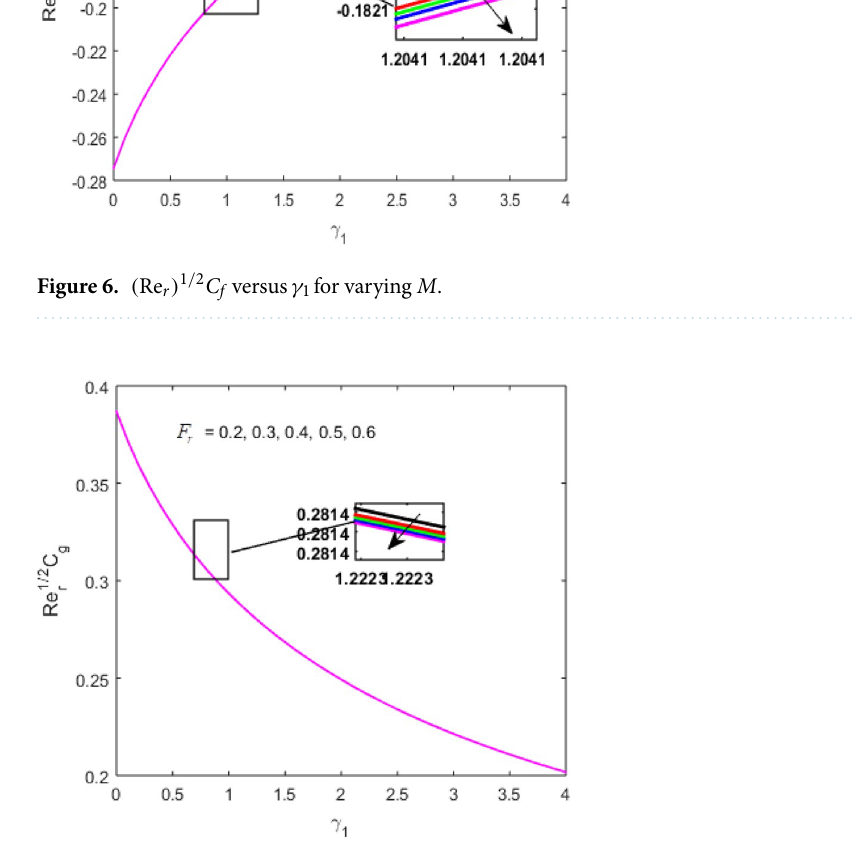
Figure 7. ( Re r ) 1 / 2 C g versus γ 1 for varying F r